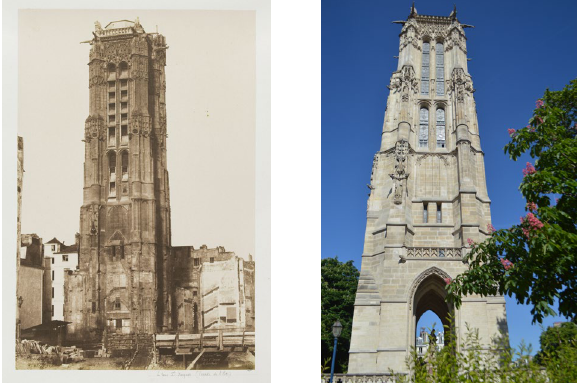
Figure 4. Tour Saint Jacques in a historical photograph by Merville and in the actual state.